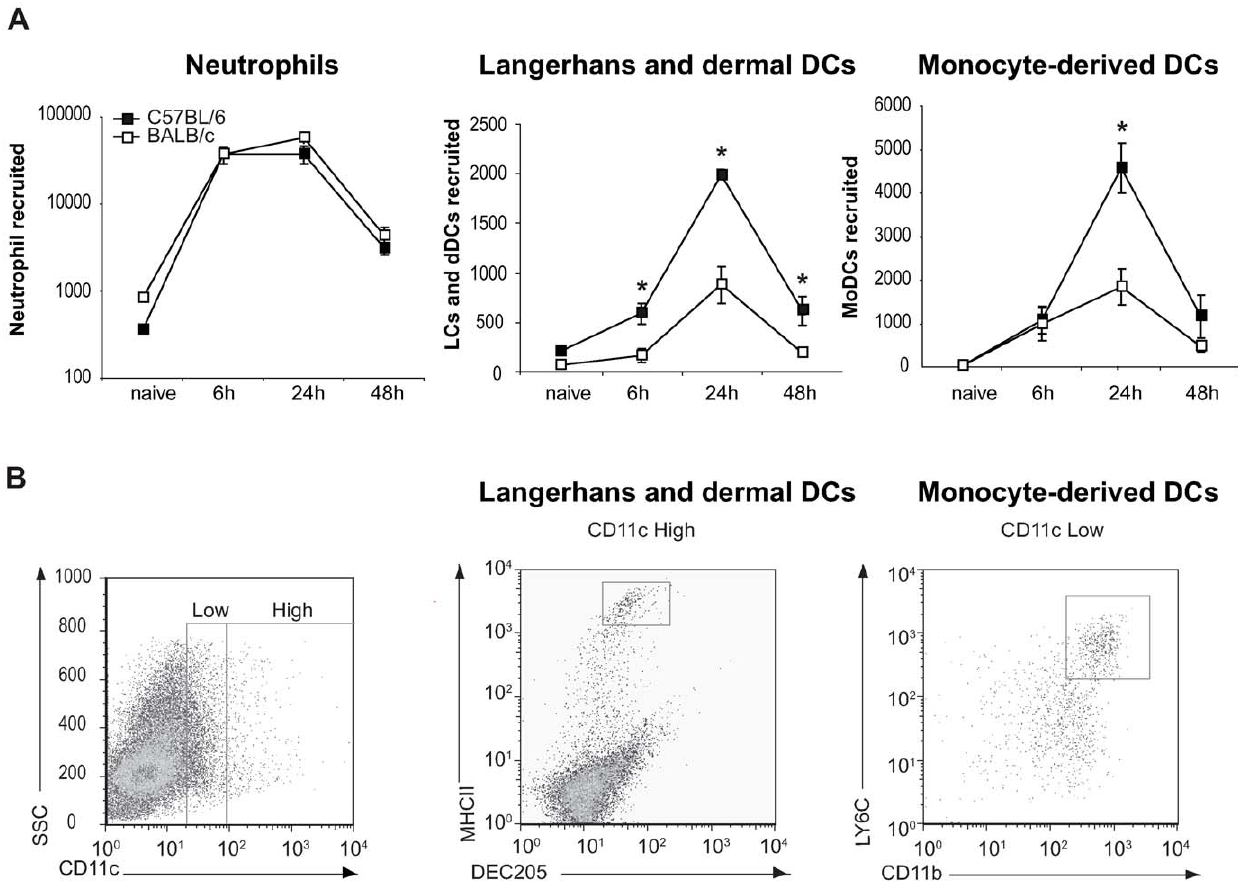
Figure 2. Higher number of DCs are recruited to the ear dermis of L.major infected C57BL/6 compared to BALB/c mice. (A) The number of neutrophils, Langerhans and dermal DCs, and monocyte-derived DCs emigrating from ear explants was measured at 0, 6, 24 and 48 hours post L. major inoculation *: p , 0.05 comparing cell number in C57BL/6 versus BALB/c mice. Values from ear explants of six mice per group are expressed as mean values 6 SEM . The data are representative of three separate experiments. (B) Gating strategy by flow cytometry of Langerhans and dermal DCs, and monocyte-derived DCs emigrating from L. major -infected C57BL/6 ear explants. For Langerhans and dermal DCs, MHCII and DEC205 positive cells were analyzed on CD11c + gated cells. For monocyte-derived DCs, four colour FACS analysis was performed, CD11b + and LY6C + cells were analyzed on a CCD11c dim and Ly6G 2 gated cell population. A representative flow cytometry plot is shown.